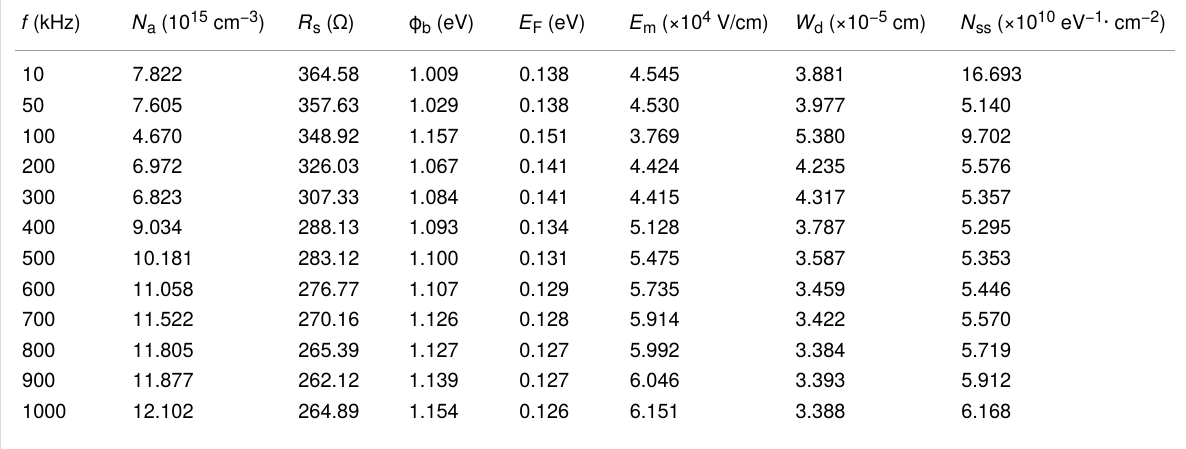
Table 2: Electrical parameters calculated from C − 2 – V plots of the Au/CuNiCoS 4 /p-Si photodiode for different frequencies. f (kHz)